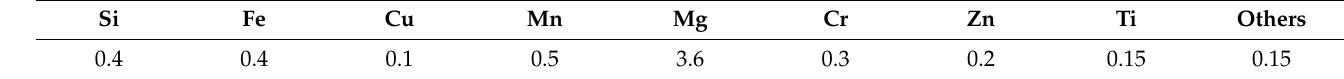
Figure 1. CAD model of the designed sample. Table 1. Maximum weight ratio of alloying elements [%] of material EN AW 5754.